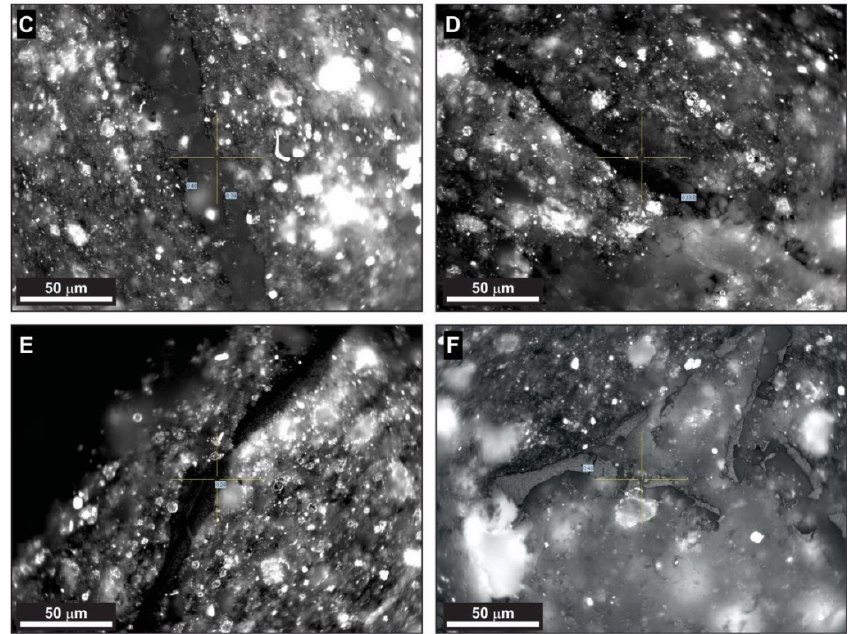
Figure 5. Photomicrographs of solid bitumen A in whole-rock polished blocks. Reflected white light ( A , C–F ); fluorescence mode ( B ).